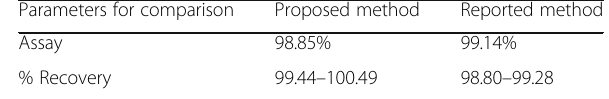
Table 6 Comparison of proposed method with the reported methods for analysis of APL (Lonkar et al. 2017a, 2017b) Parameters for